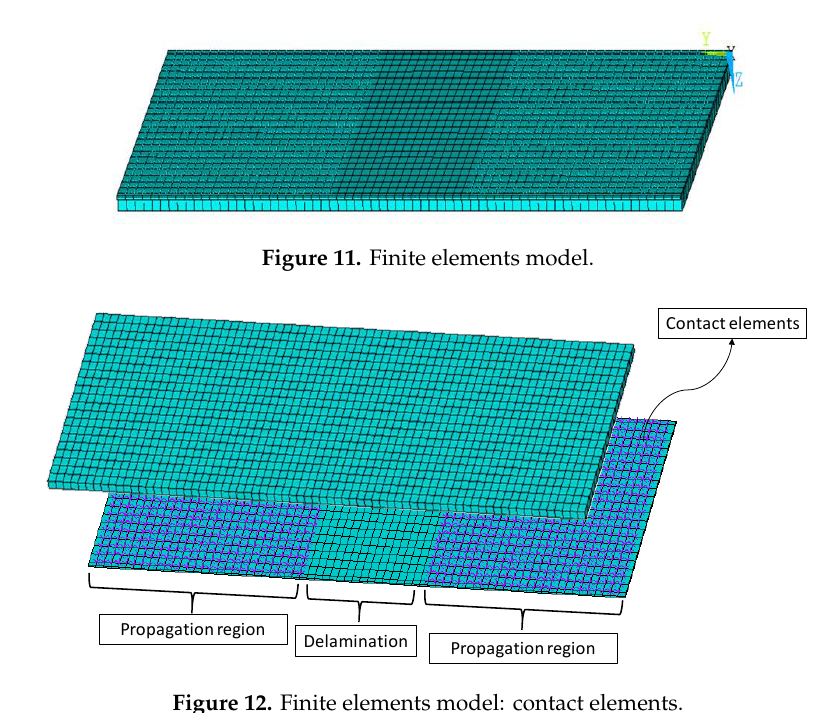
Figure 12. Finite elements model: contact elements.